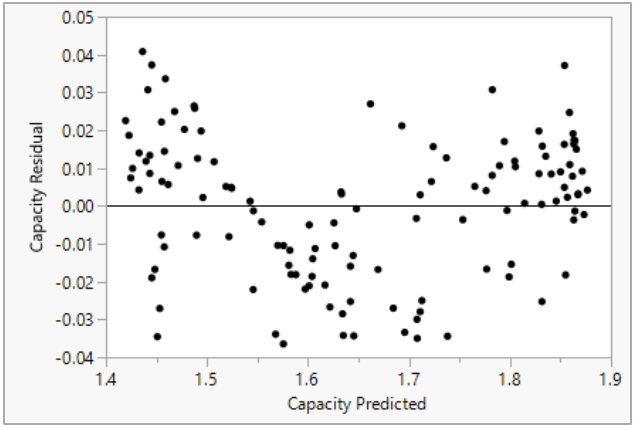
Figure 5. Actual versus predicted capacity for training and testing datasets.